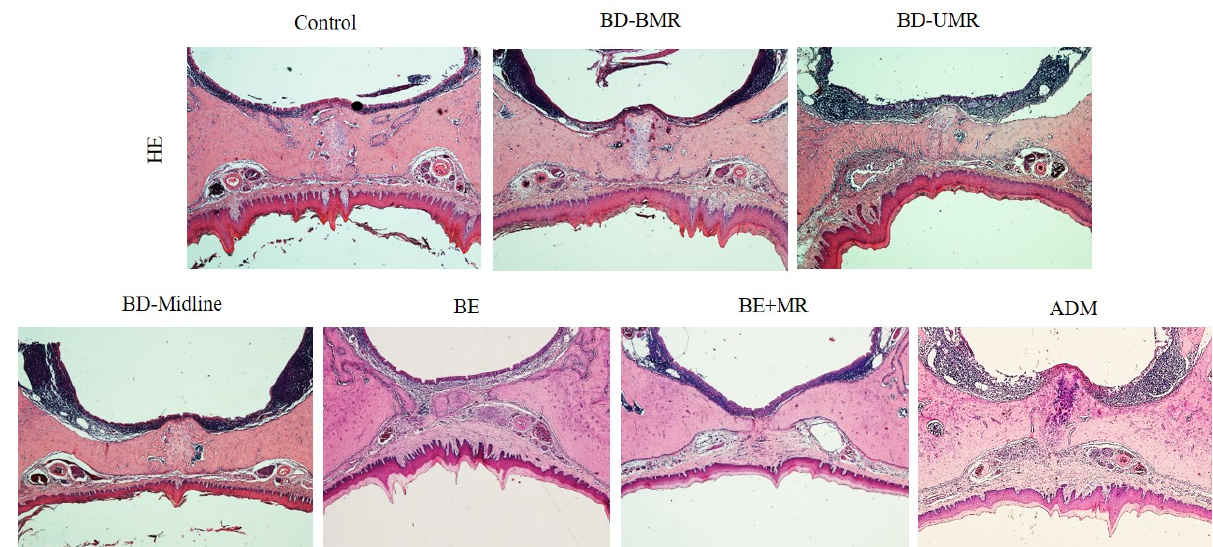
Figure 5. The representative histological finding with hematoxylin-eosin (HE) stains of the palate after various degrees of the palatal wound and ADM treated palatal wound nine weeks after surgery. Compared with the control, BD-BMR, BD-UMR, BD-midline, BE, and BE + MR, the thickness of the mucoperiosteum in the trauma area increased and the regenerated soft tissue is full of new small blood vessels. However, the periosteum thickness was almost not observed at the surgical site.